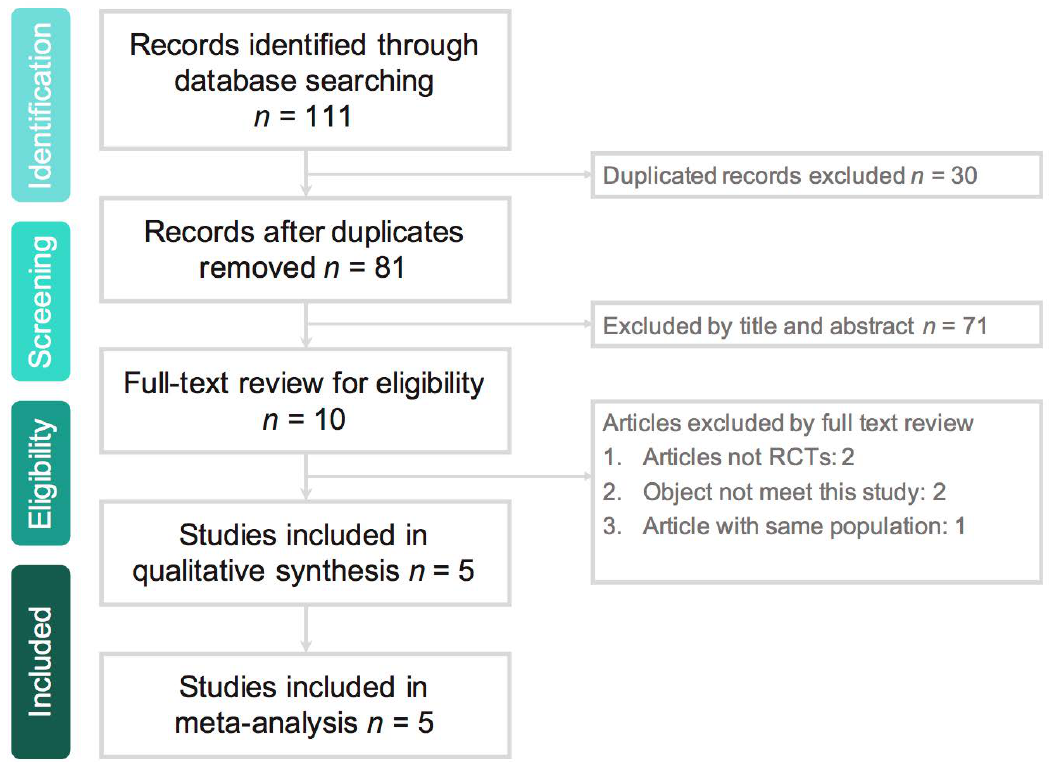
Figure 1. Study selection process flow. RCT: randomized controlled